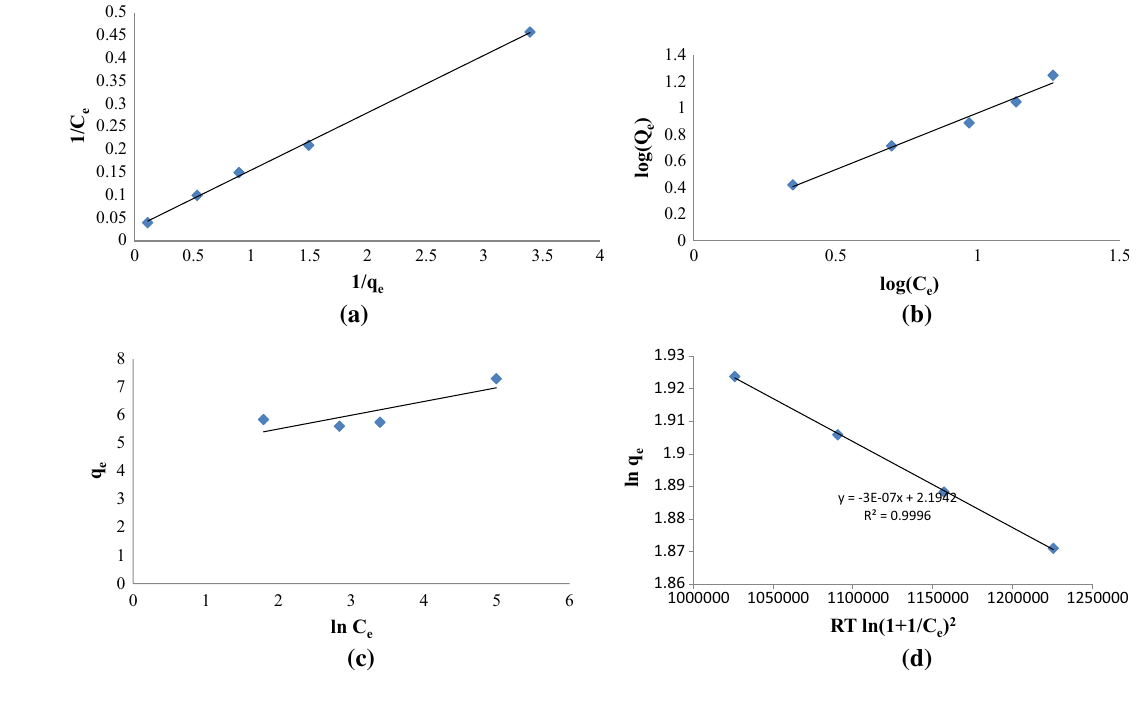
Fig. 4 a Langmuir, b Freundlich, c Temkin, d D–R isotherm studies